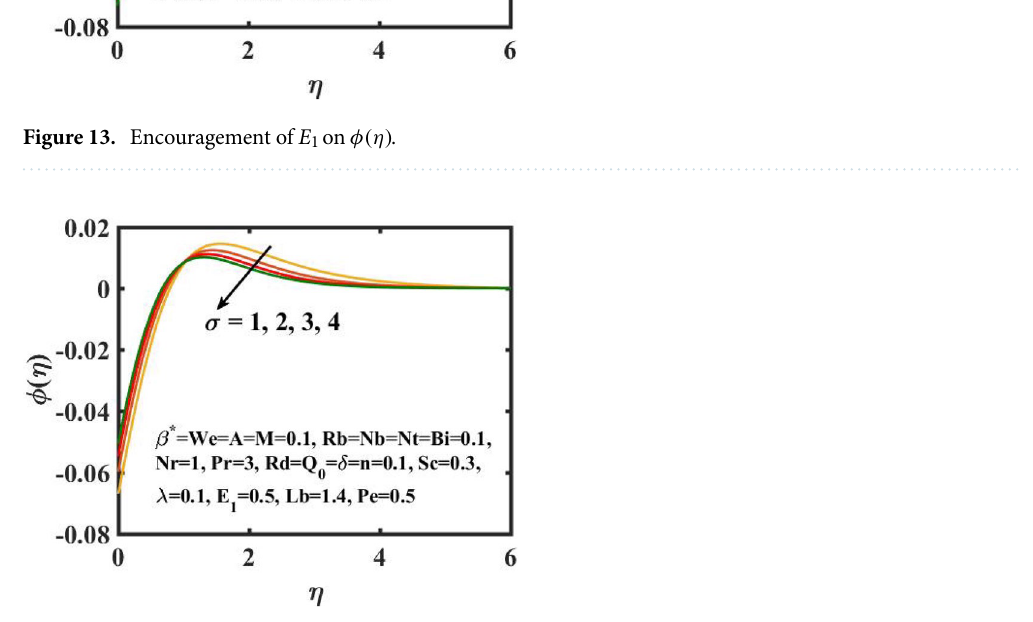
Figure 14. Encouragement of σ on φ(η)